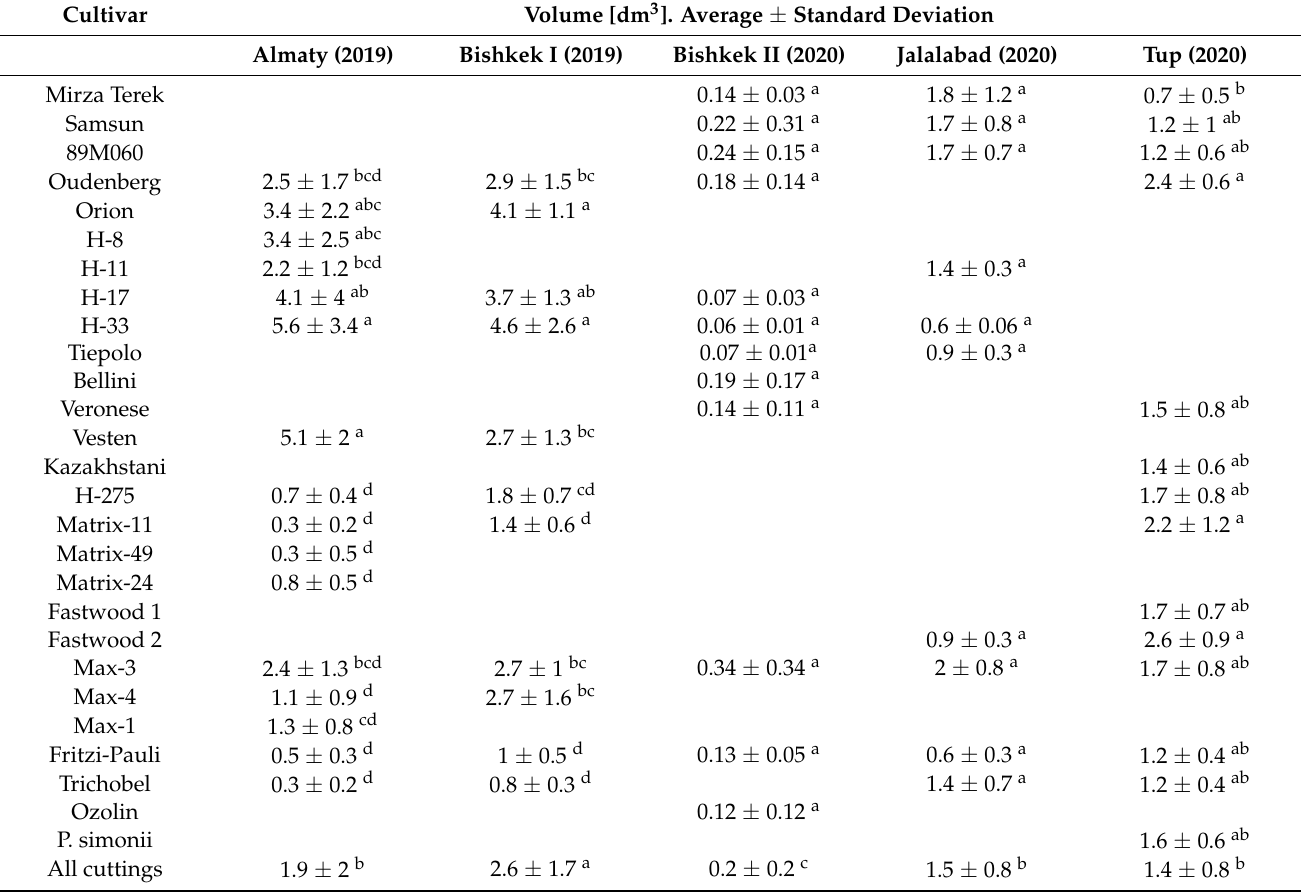
Table 8. Means ± standard deviations of stem volumes [dm 3 ] after two growing seasons for the sites Bishkek I and II, Almaty, Jalalabad and Tup. Sample sizes, minima, and maxima are listed in Table S3. Letters indicate groups of values that do not differ significantly at α < 0.05. The last row contains means ± standard deviations by sites with all cuttings pooled together by site. Letters here indicate groups of sites that do not differ significantly at α <